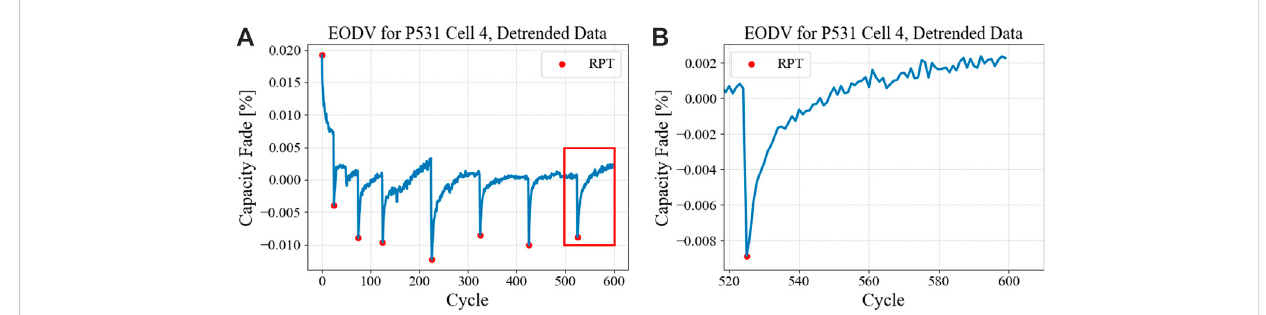
FIGURE 8 CBCpro fi lesforEODVofanNMC811/Grcellcyclingata4CCCCVchargerate, (A) coveringtheentiretestperiodand (B) isolatingthe fi nalpost-RPT segment to demonstrate the magnitude of PH. In (A) the red dots represent the voltage in the CBC cycle that immediately follows an